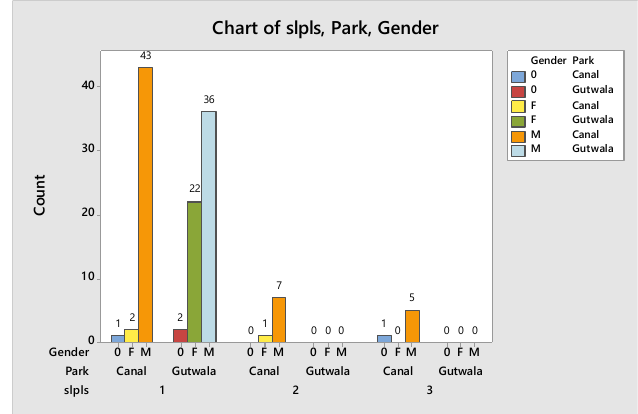
Figure 18: Bar Chart of Sleep Loss problem between both sites Graphical representation in fig.18 clearly indicates that 5male and 3 female out of 60 visitors responded highly affected by the sleep loss problem due to noise pollution while 7 male and 1 female out of 60 showed mild, no one out of 60 showed low, ale and 2 female showed nil and 2 out of 60 did not show any response in the site-1 Canal Park, contrarily, all sampled 60 visitors including both male and female except 2 visitors in the Site-2 Gat Wala Park did not show any symptom of Sleep Loss due to noise pollution.